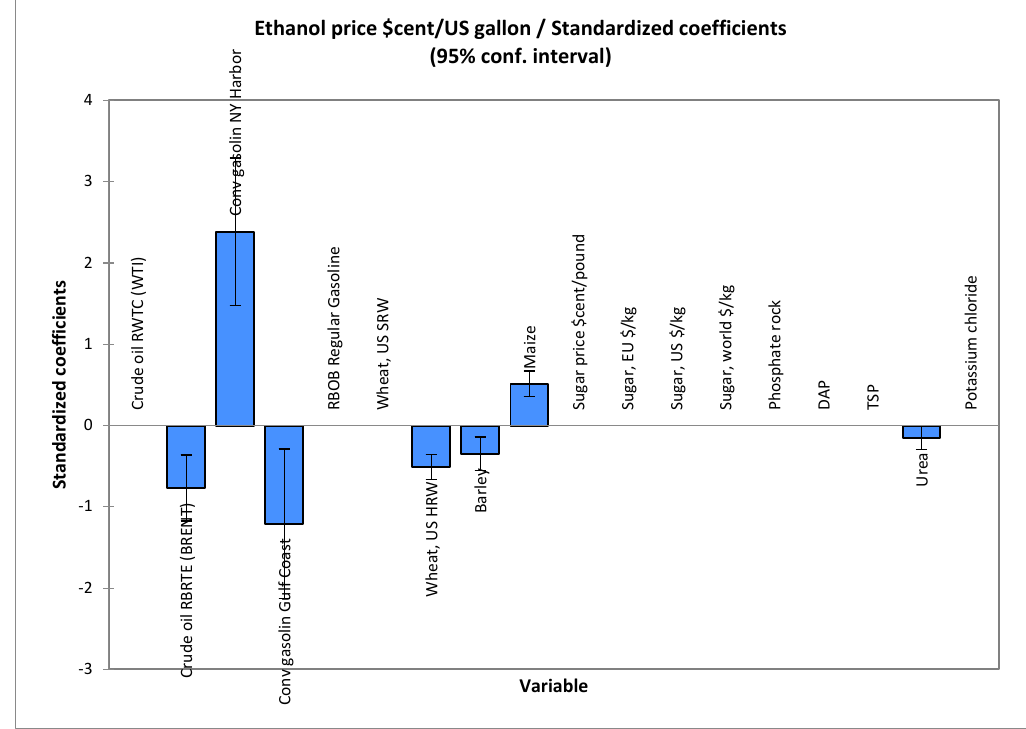
Figure 11. Impacts of the significant variables on the ethanol price without COVID. Note: The blue bars show the average values, while their lines indicate the minimum/maximum intervals of the coefficients analyzed.